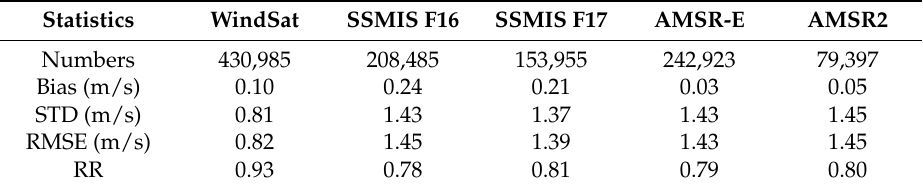
Table 2. The overall statistical results between satellite wind speeds and buoy observations.